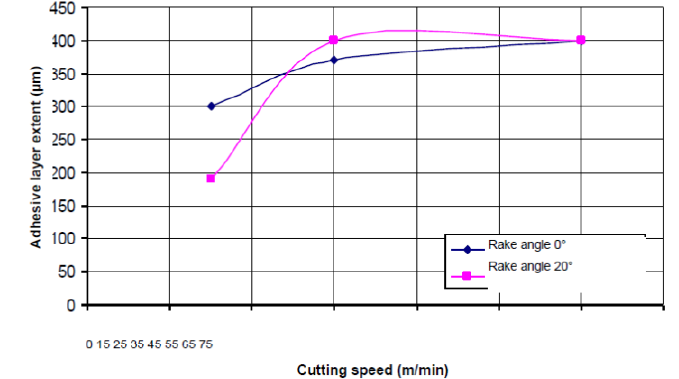
Figure 21. Evolution of the adhesive layer extent on the tool surface during machining Ti-6Al-4V with different cutting